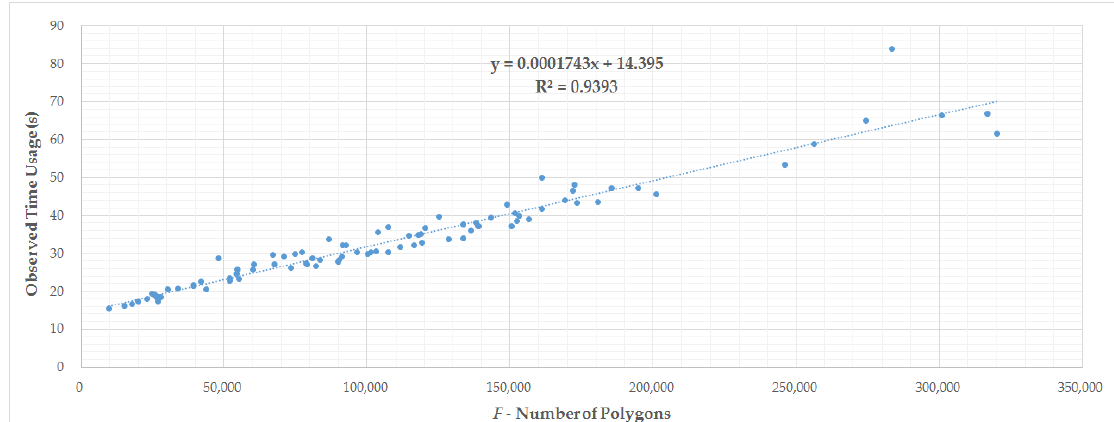
Figure 6. Linear regression of P 1 (This is the relation between the number of polygons and the time usage in data movement , where F is the number of polygons).